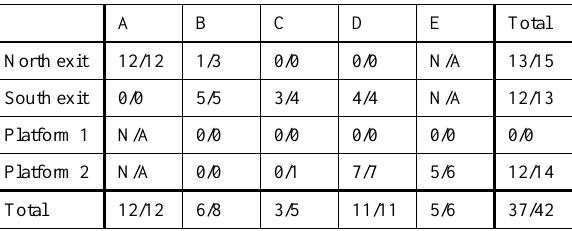
Figure 8. Passenger flow Table 9. Ticket gate choice with origin information